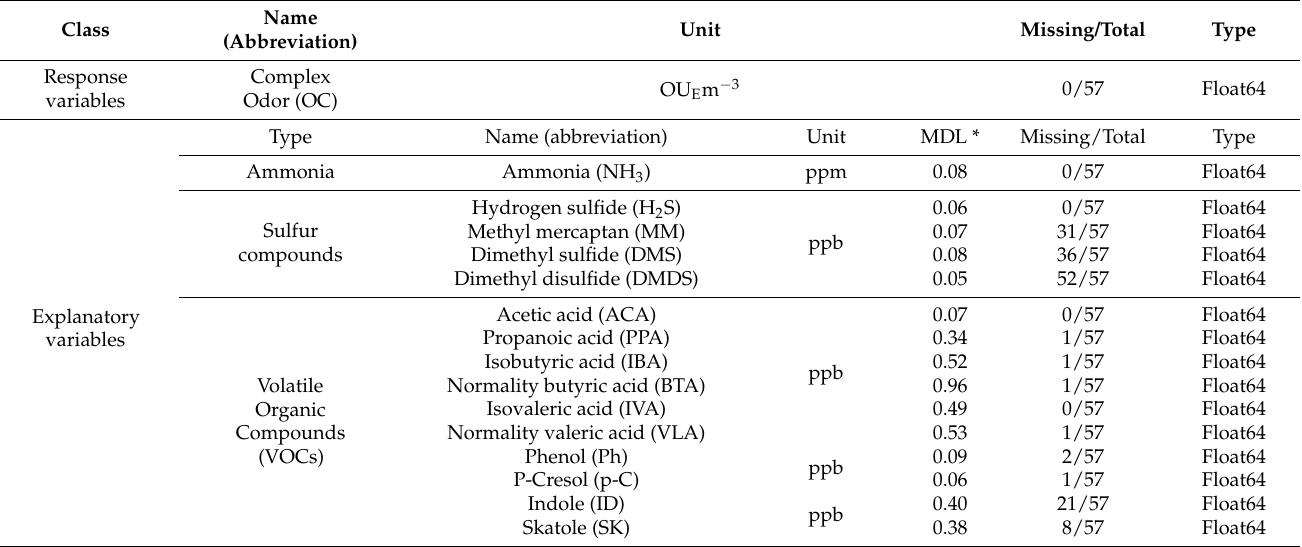
Table 2. Summary of complex odor and odor substances.